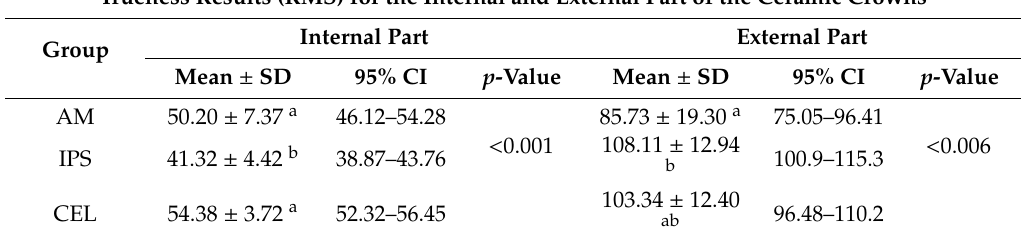
Table4. ResultsoftruenessRootMeanSquare(RMS)forinternalandexternalpartsoftheceramiccrowns. Trueness Results (RMS) for the Internal and External Part of the Ceramic Crowns Internal Part External Group